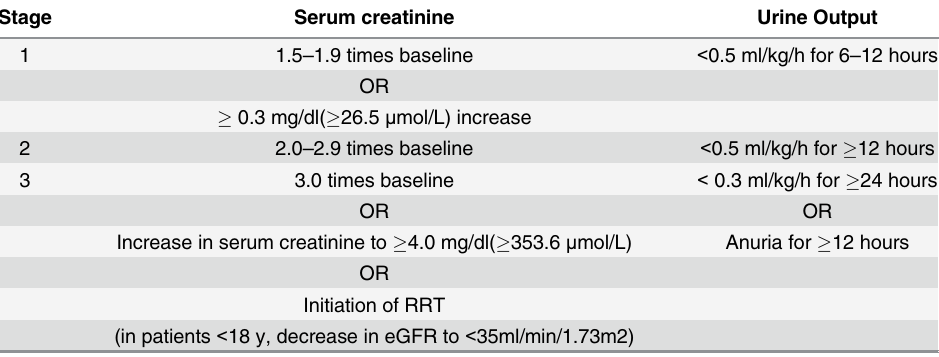
Table 1. KDIGO criteria for AKI diagnosis.